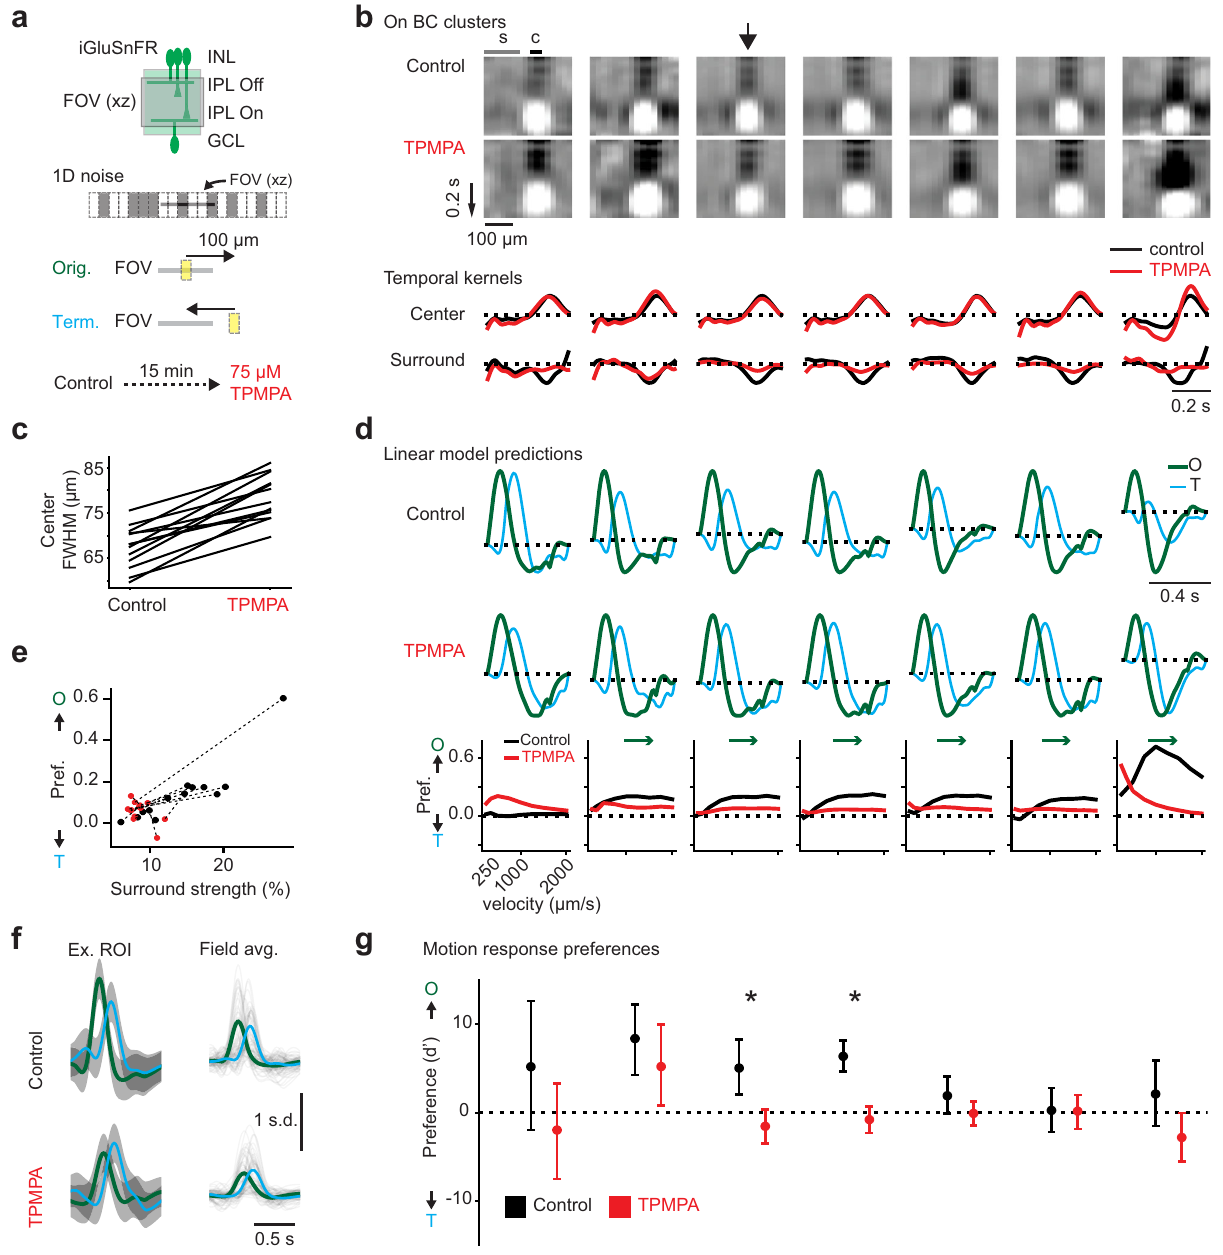
Fig.5|BlockofGABA C receptorsweakensradialdirectionselectivityintwoOn bipolarcellclusters.a Top:iGluSnFRimaging.Middle:Movingbarstimulusand “ 1D noise ” stimulus to measure radial direction selectivity (rDS) and assign cluster membership and predict motion responses. Bottom: drug treatment, see Methods for details. b Top: average RF of each cluster in control and in TPMPA. Arrow indicates the cluster whose average motion responses are shown in ( f ). Bottom: temporal RFs averaged from center ( “ c ” ) and surround ( “ s ” ) regions indicated above, normalized to their respective peaks. Temporal RFs in TPMPA (red) are normalized to the responses in control condition (black). Sample size is 3544 ROIs/ 3 fi elds/ 3 mice. c Full width half max- imum(FWHM)ofthespatialRFincontrolandTPMPA. d Top:linearconvolution modelpredictionsfororiginating( “ O ” )andterminating( “ T ” )motionusing RFs from control or TPMPA conditions. Velocity, 1000 μ m/s. Bottom: velocity tuning from these model predictions in control and TPMPA. e rDS of each